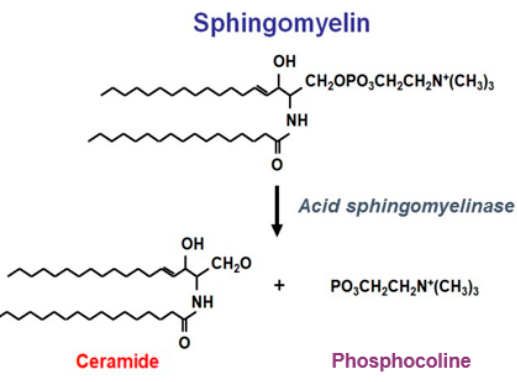
Figure 1. Enzymatic action of acid sphingomyelinase (ASM). Normal physiological function requires ASM to catalyse the hydrolysis of sphingomyelin to ceramide and phosphocoline. Ceramides have a proinflammatory effect as they are bioactive sphingolipids that act as second messengers which transduce pro-inflammatory signals.